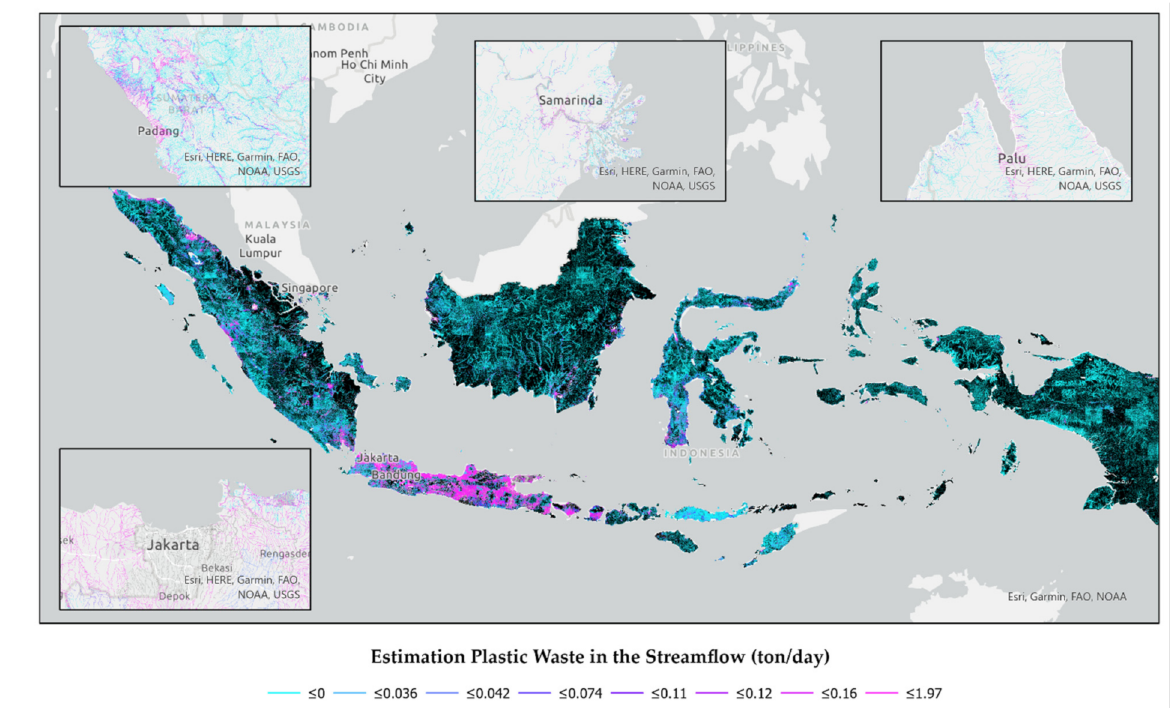
Figure 7. The flow of plastic waste from streamflow (tonne/day).